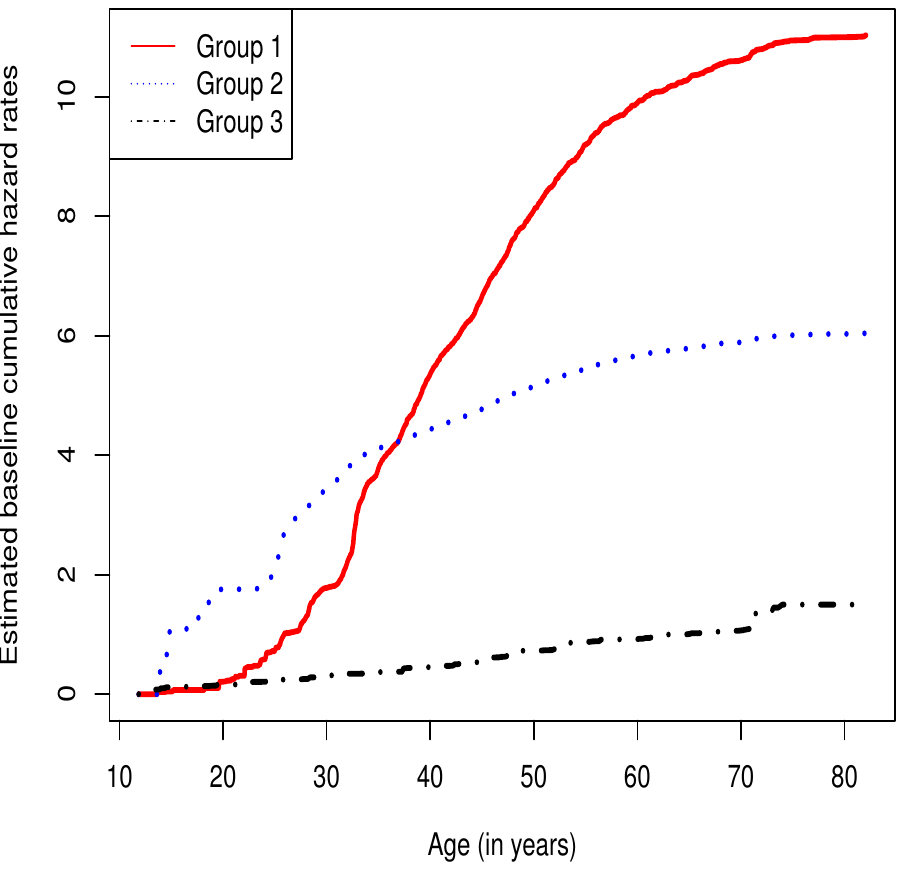
Figure 2. The estimated baseline cumulative hazard functions for migraine data in the optimal model with three